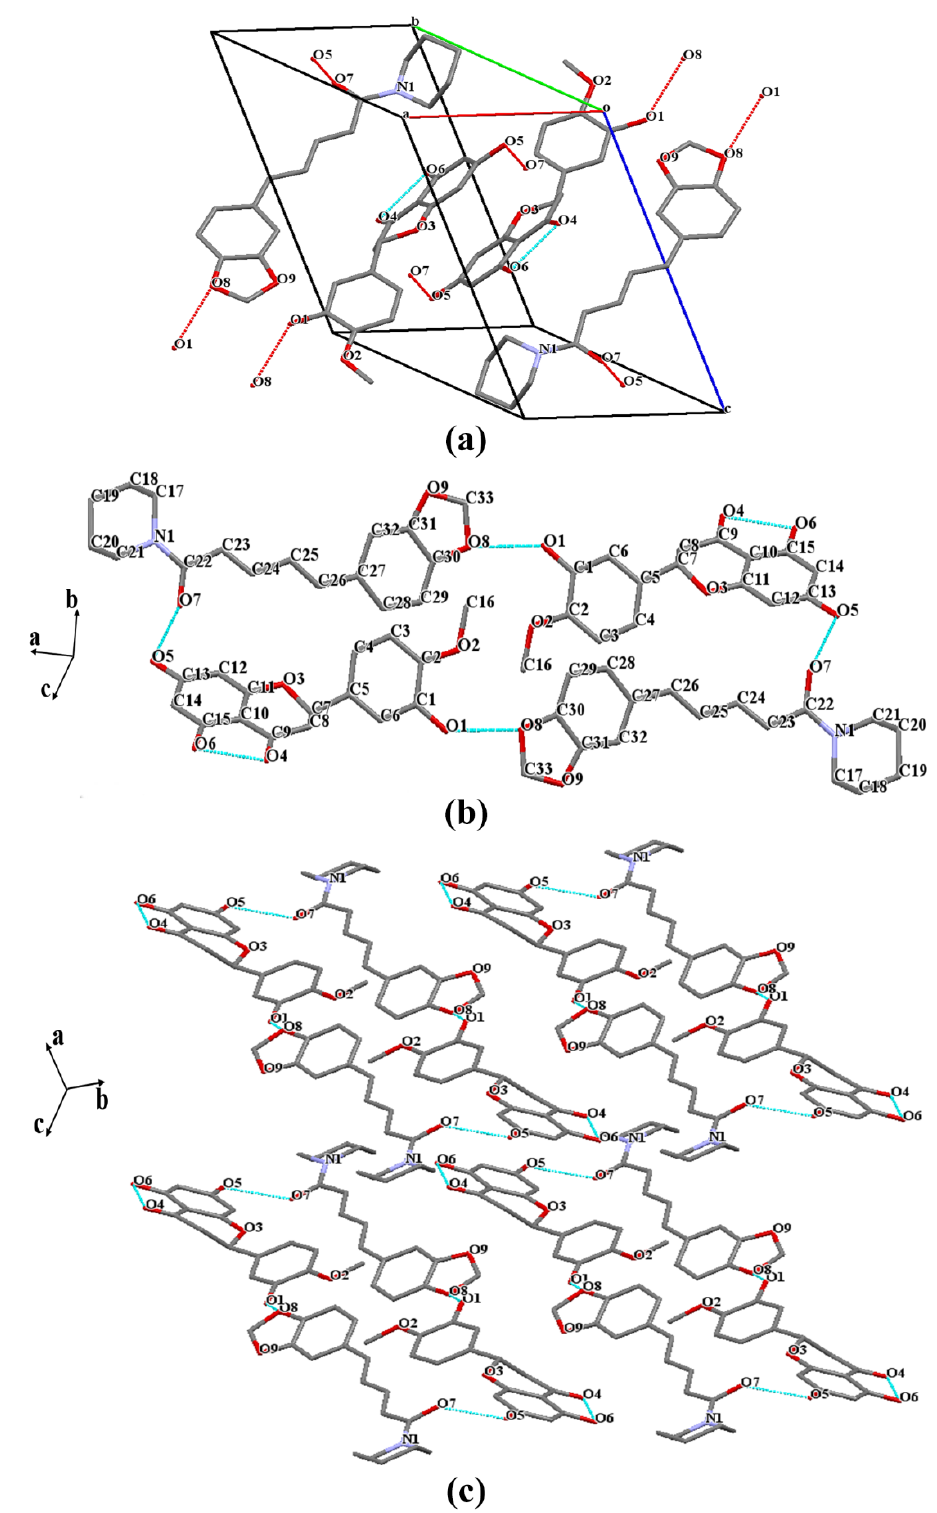
Figure 3. ( a ) Cell packing, ( b ) 2D and ( c ) 3D hydrogen-bonded frameworks of HES–PIP. H-bonds are represented by dashed lines. represented by dashed